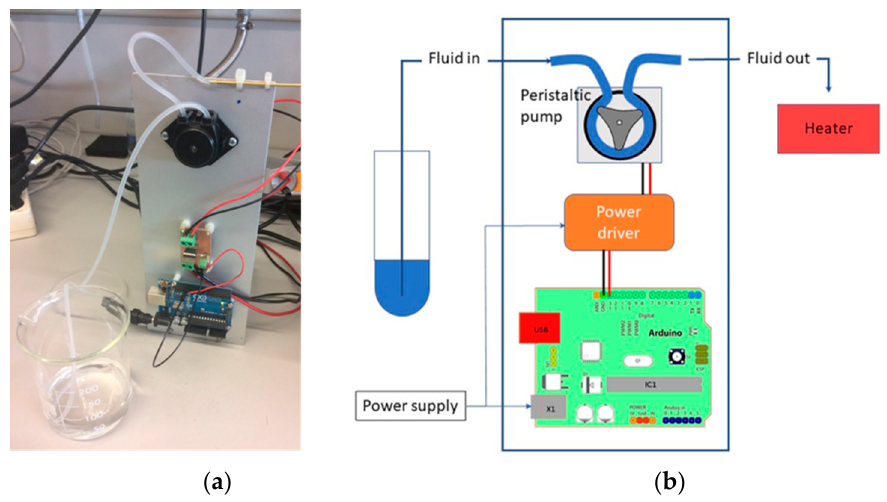
Figure 3. Odor delivery system: ( a ) photo; ( b ) schematic.